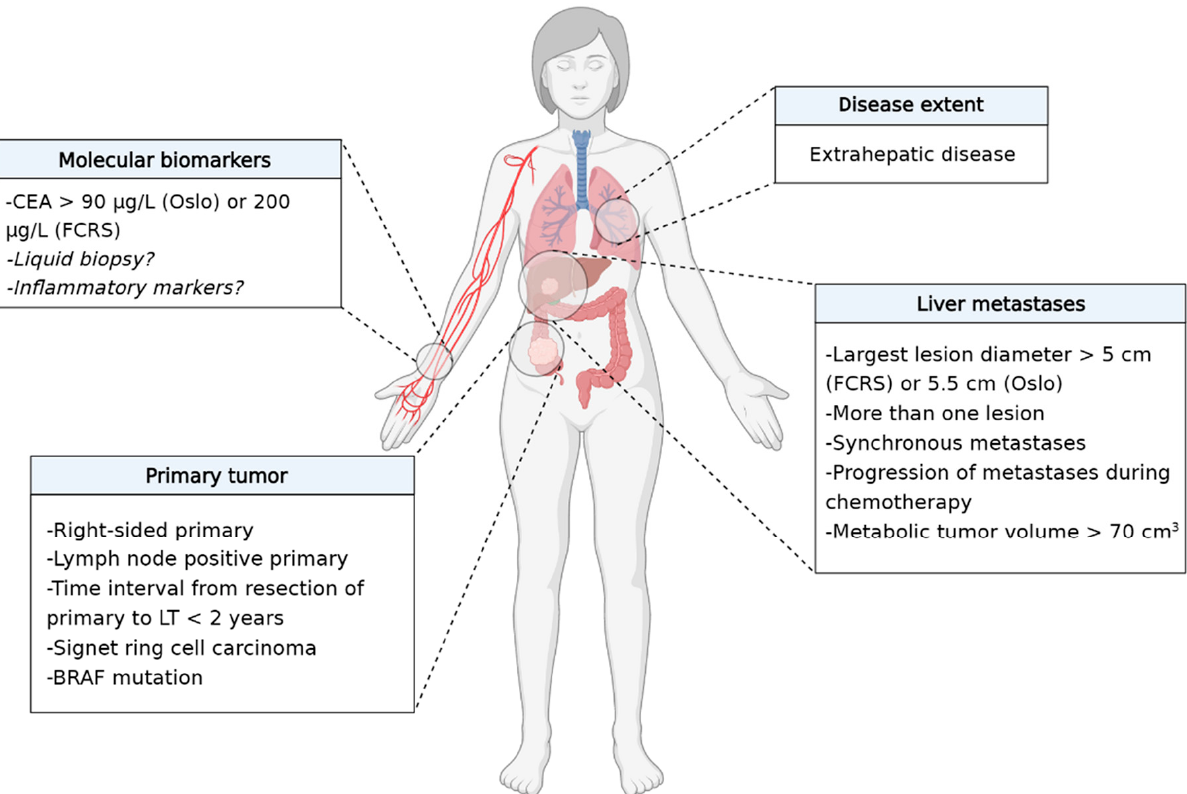
Figure 2. Established and potential risk factors associated with poor prognosis after liver transplantation for colorectal liver metastases.